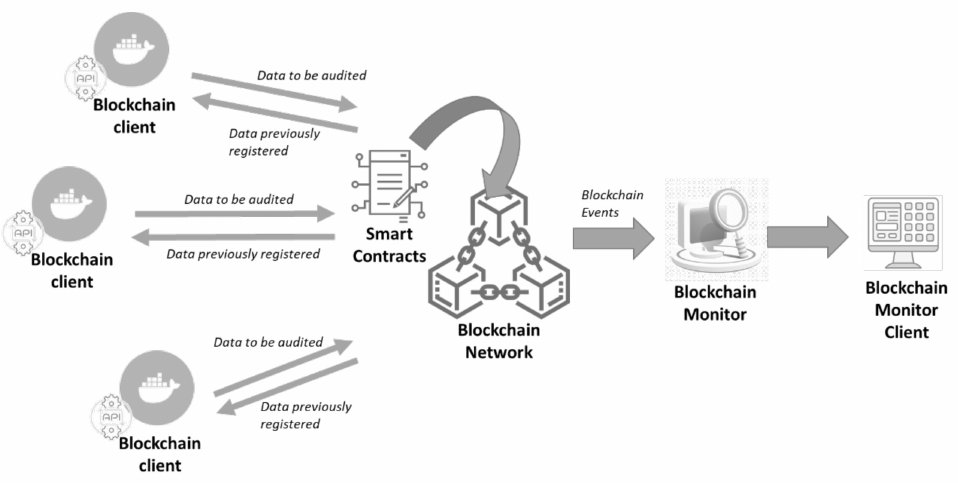
Figure 1. Audit trail mechanism